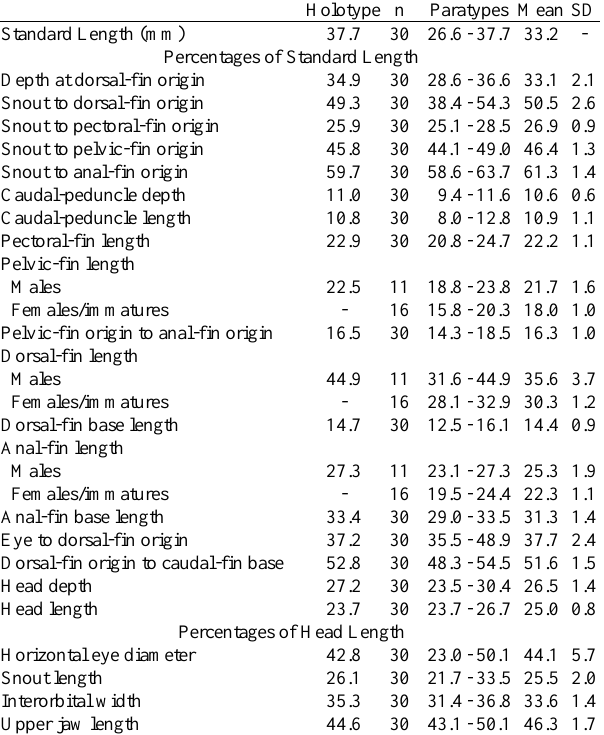
Table 1. Morphometric data of Tetragonopterus akamai . Values are given as percents of standard length or head length. Range includes the holotype (n = number of specimens; H = holotype; Min. = minimum; Max. =